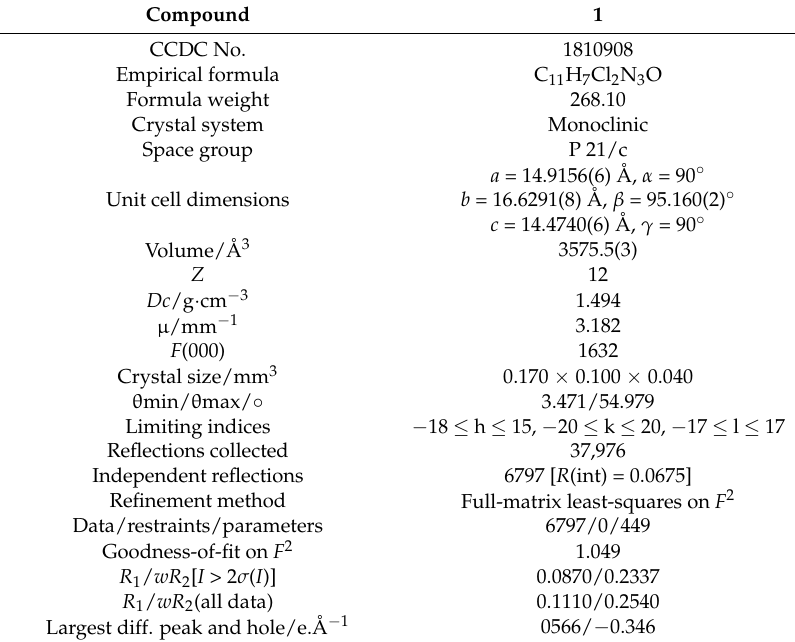
Table 1. Selected crystallographic data of Compound 1 .